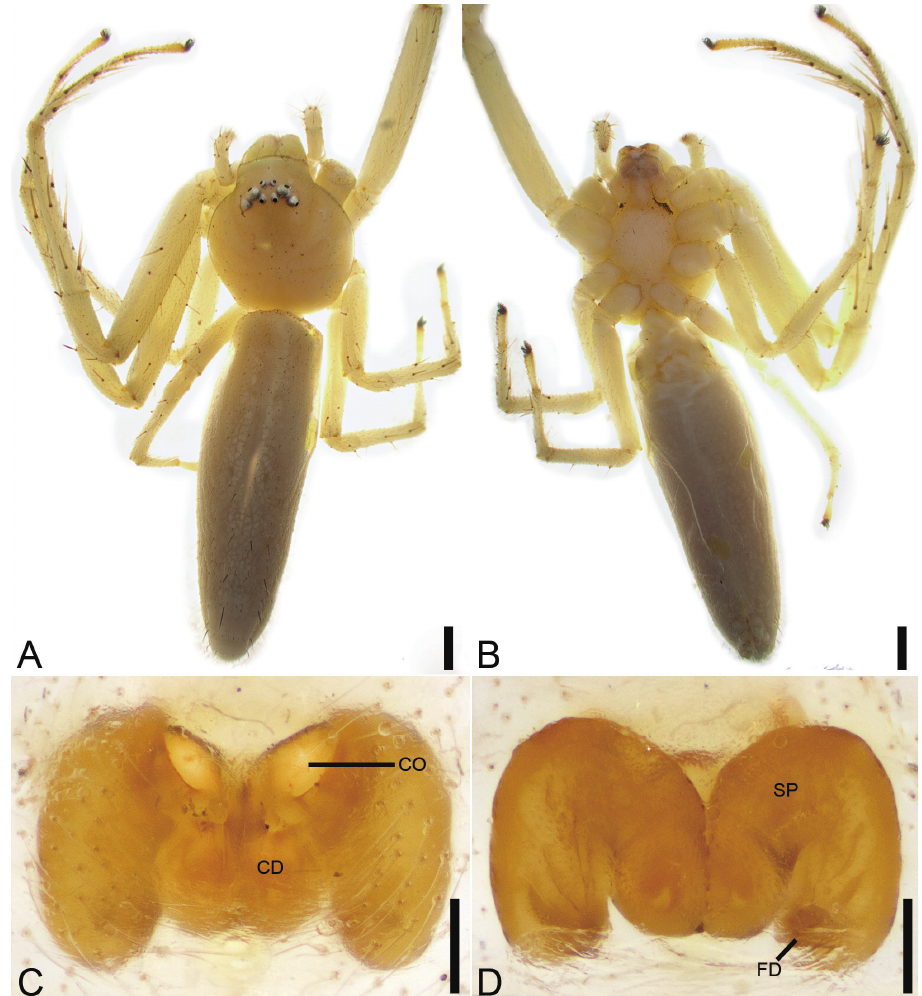
Figure 10. Oxytate mucunica sp. nov., female. A habitus, dorsal view B same, ventral view C epigyne, ventral view D same, dorsal view. Abbreviations: CD – copulatory duct, CO – copulatory opening, FD – fertilisation duct, SP – spermatheca. Scale bars: 0.5 mm ( A, B ), 0.1 mm ( C, D